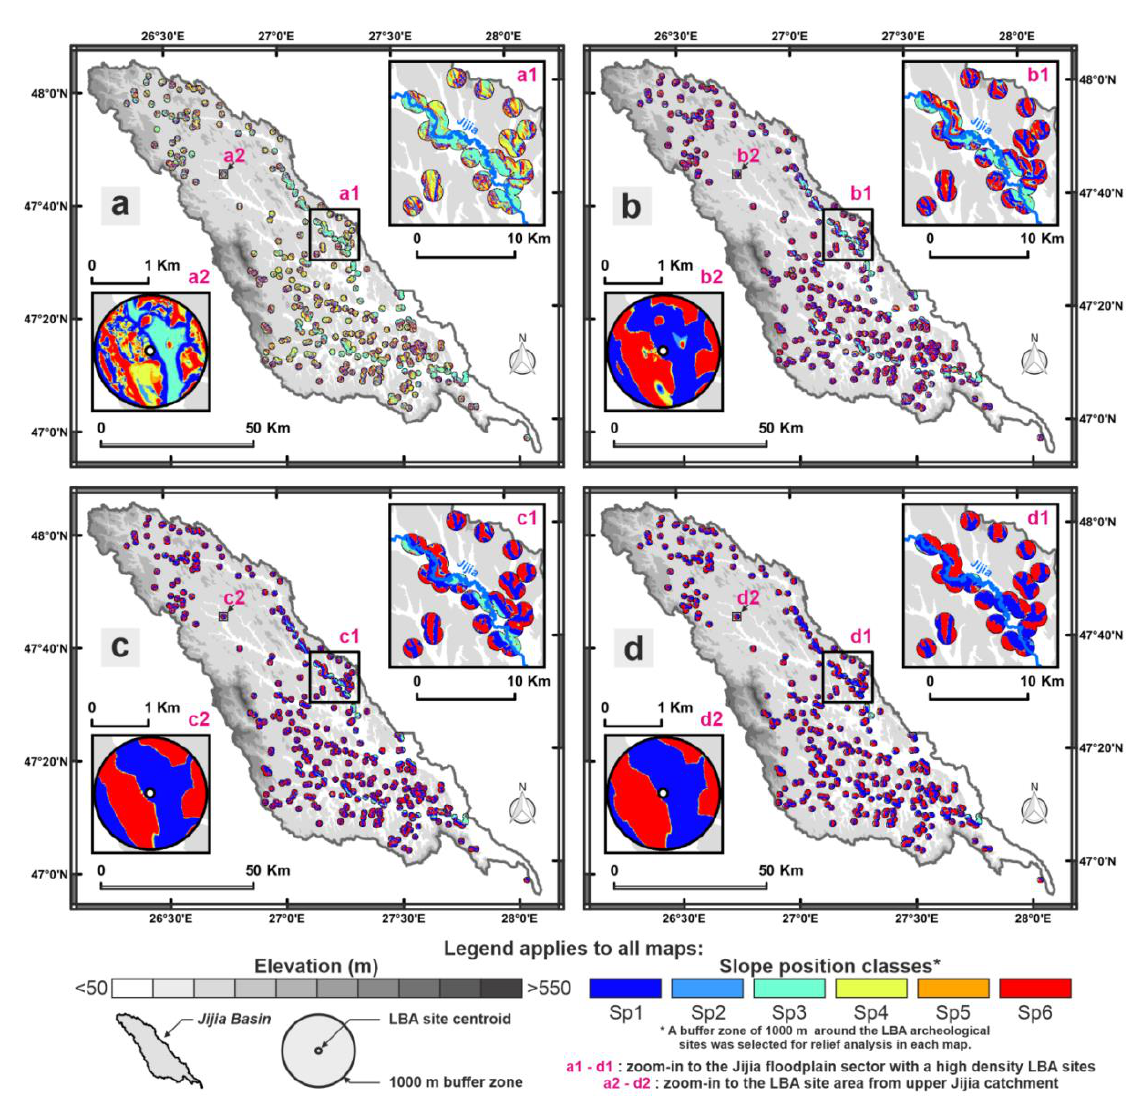
Figure 5. Slope position classification based on TPI-derived DEV of the LBA archaeological sites (Noua Culture) in the Jijia catchment, with six morphological classes (see Table 1); the relief analysis was provided for four TPI-derived DEV neighborhood sizes: ( a ) 100 m, ( b ) 300 m, ( c ) 600 m and ( d ) 1200 m. Table 3. Number of LBA archaeological sites occurring over six slope position classes in the Jijia catchment (see Figure 5).